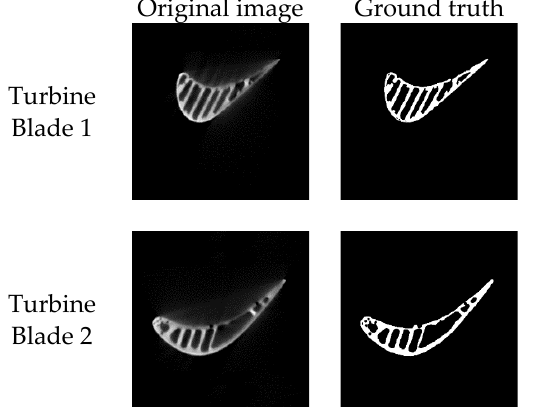
Figure 5. Training data samples of two turbine blades.